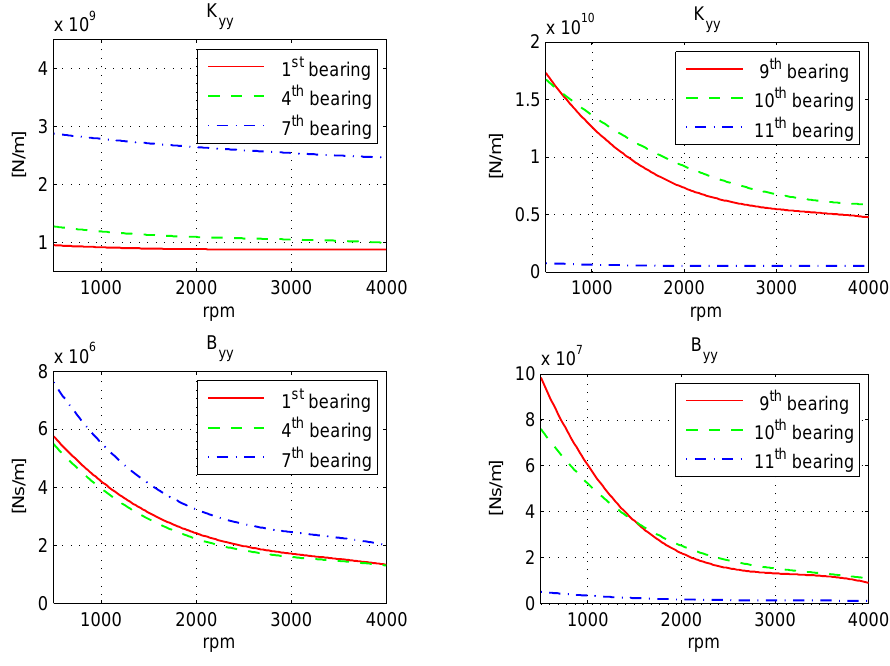
Figure 6. Illustration of stiffness ( K yy ) and damping ( B yy ) bearing coefficients for particular